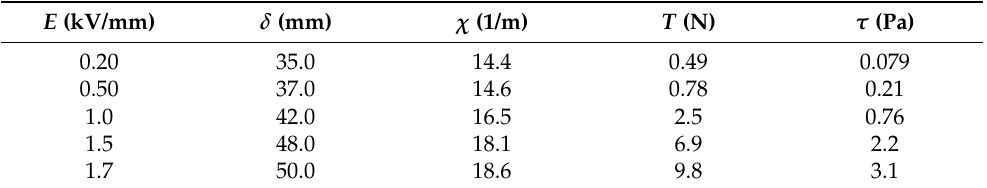
Table 1. E – τ relations.